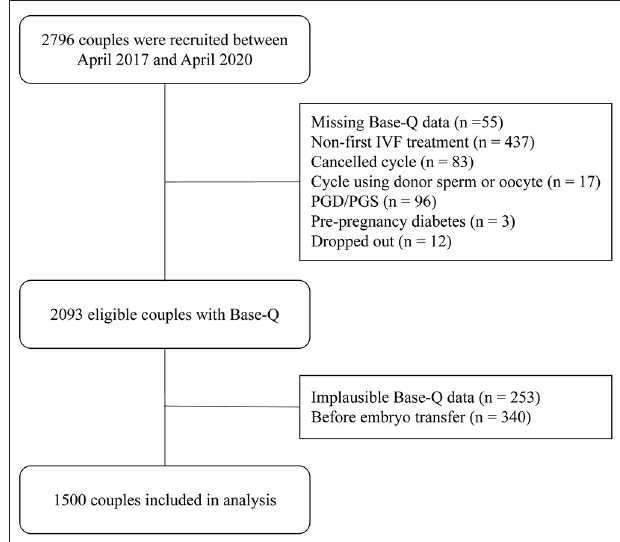
FIGURE 1 | The flowchart of the selection process of this study